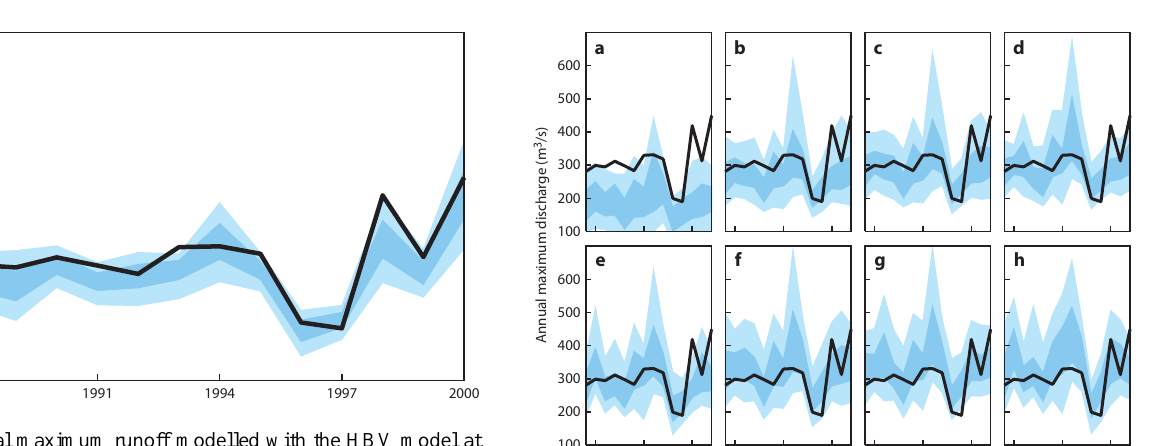
Fig. 6. Annual maximum runoff modelled with the HBV model at the station Montford with observed precipitation. The lighter blue areas show the 5th to 95th percentile, the darker blue show the 25th to 75th percentile of the parameter uncertainty for all models with NS > 0.85. The black line is observed runoff.